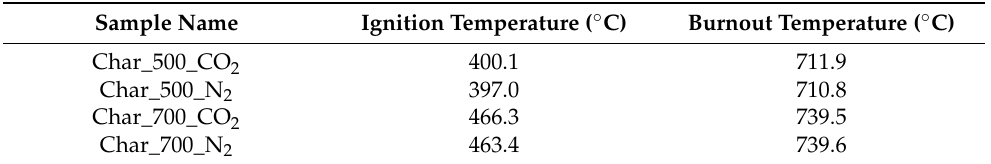
Figure 4. TG and DTG curves of char combustion which was obtained from pyrolysis under carbon dioxide and nitrogen atmosphere at ( a ) 500 °C and ( b ) 700 °C. Table 3. Ignition and burnout temperatures for chars obtained at 500 and 700 °C under carbon dioxide and nitrogen atmosphere.